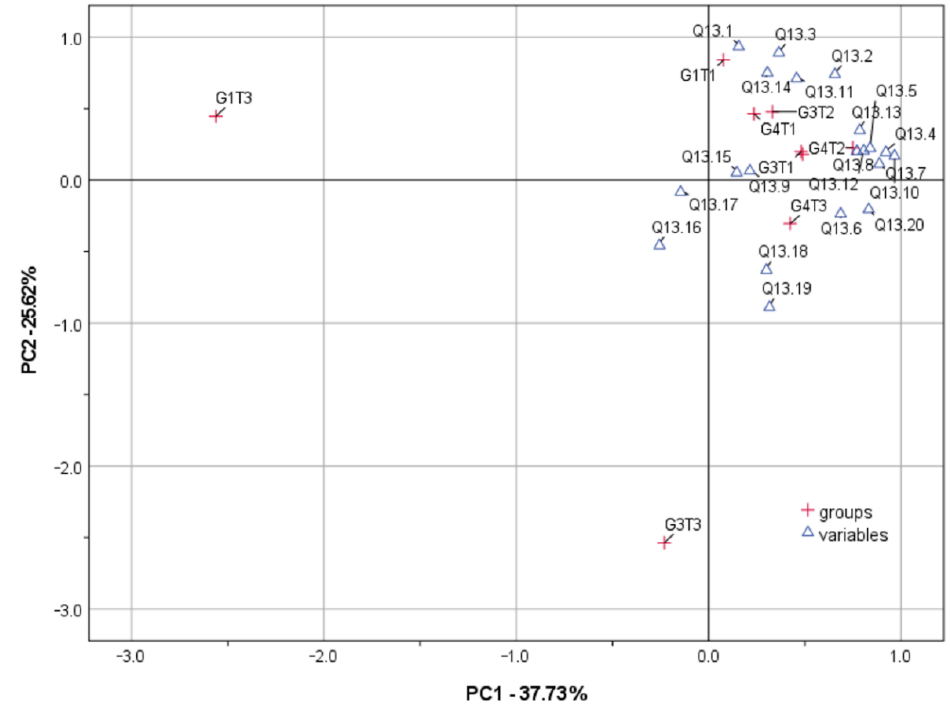
Figure 2. Biplot of relationships of variables (Q13.1, . . . , Q13.20) for groups (G1T1, . . . , G1T3, G3T1, . . . , G4T3) representing types of organization subdivided according to the declared level of trust in the space of the first two components PC1 and PC2.